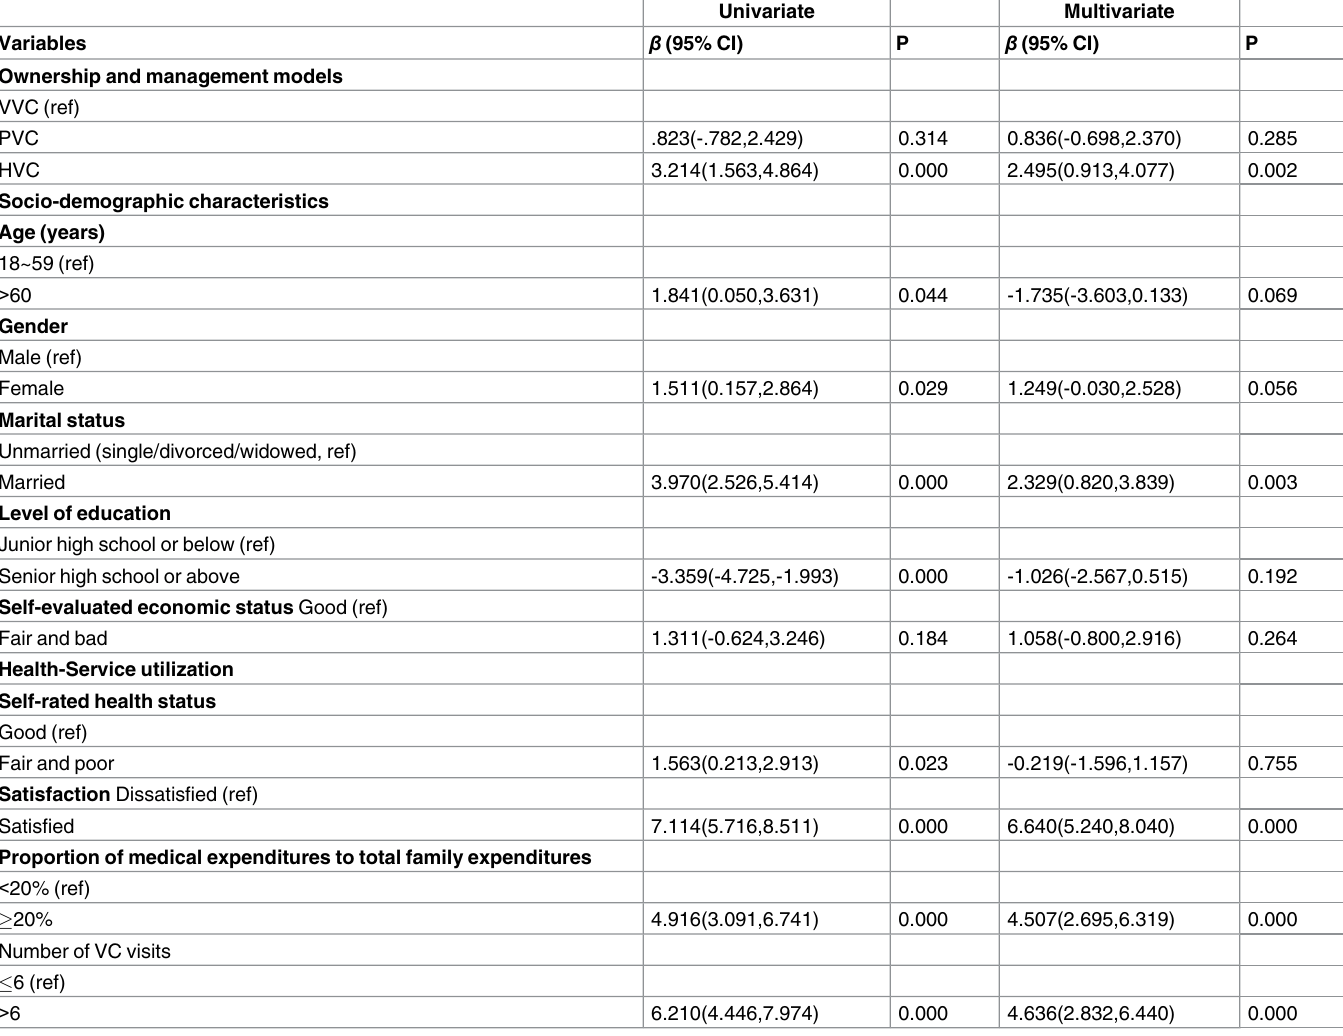
Table 4. Linear regression analysis on primary care assessment total